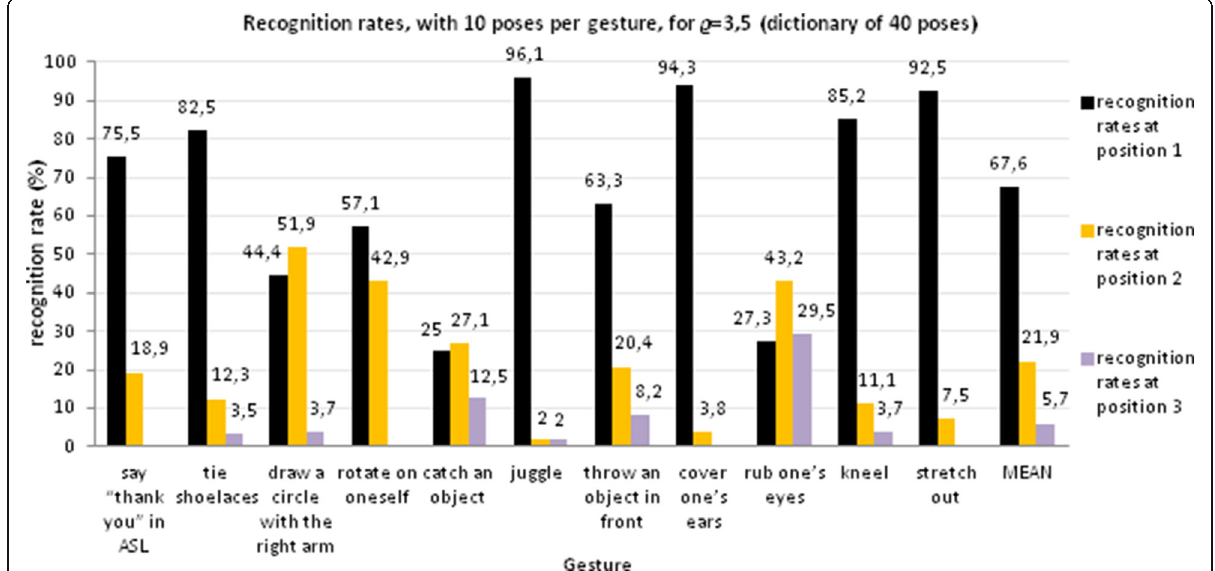
Fig. 6 Recognition rates per class for HTI 2014 – 2015 dataset